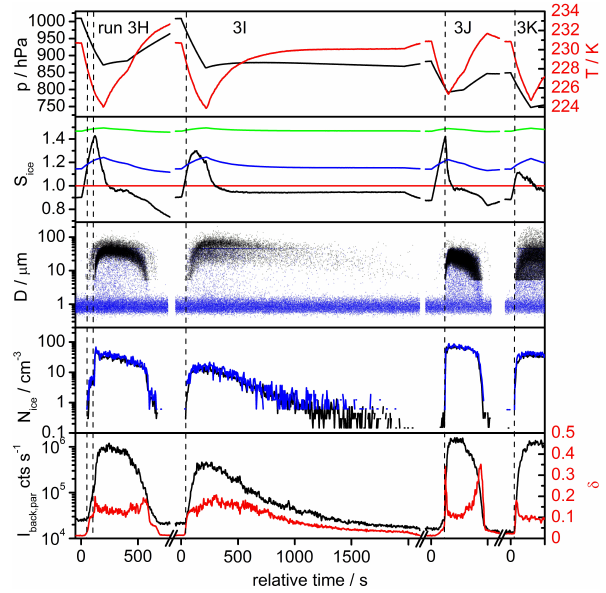
Fig. 10. Time series of various AIDA records during expansion runs 3B, 3C, 3D, 3F, 3G, and 3H with raffinose. The individual panels contain the same measurements as in Fig. 5. In each expansion run, time zero denotes the start of pumping and does not refer to the over- all time scale of the experiment shown in Fig. 9. The time periods between the expansion runs for re-establishing equilibrium condi- tions in terms of temperature and relative humidity are omitted.